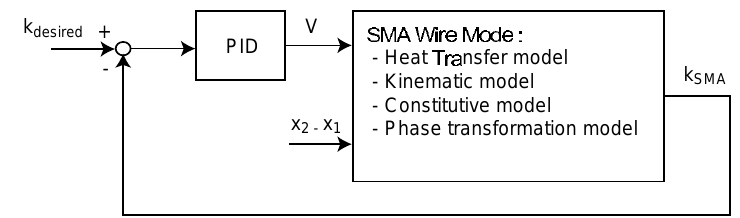
Fig. 9. Stiffness control for the tuned vibration absorber with SMA wires for variable